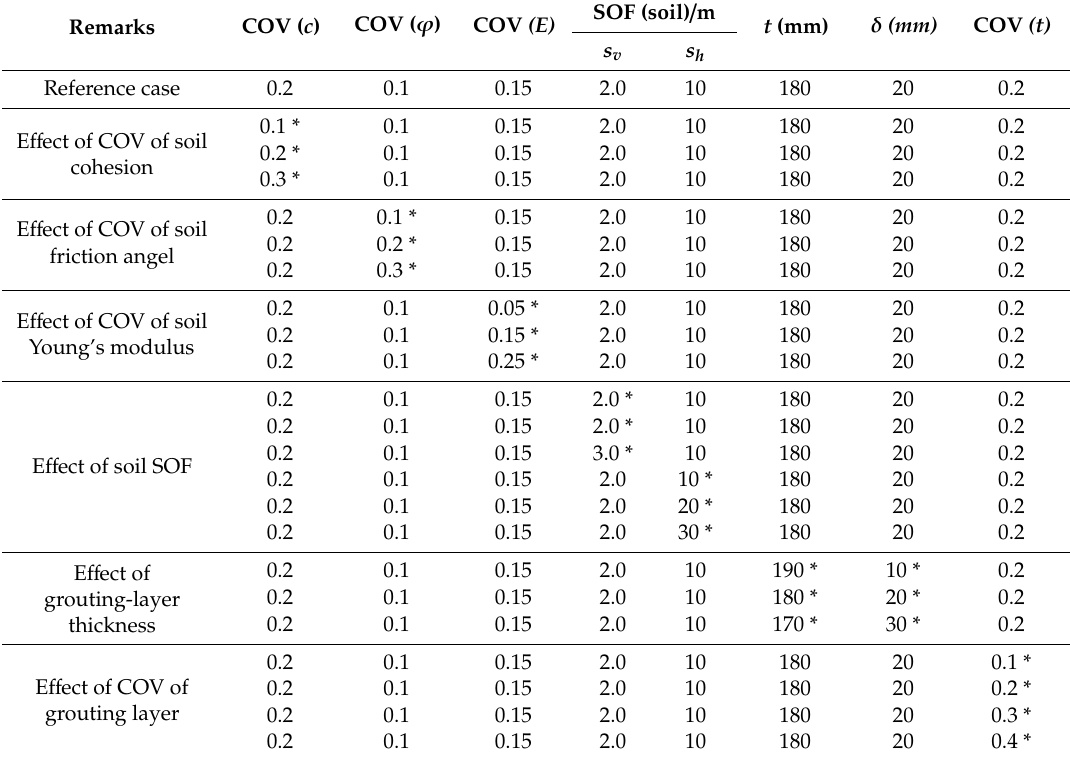
Table 3. Reference case and parametric